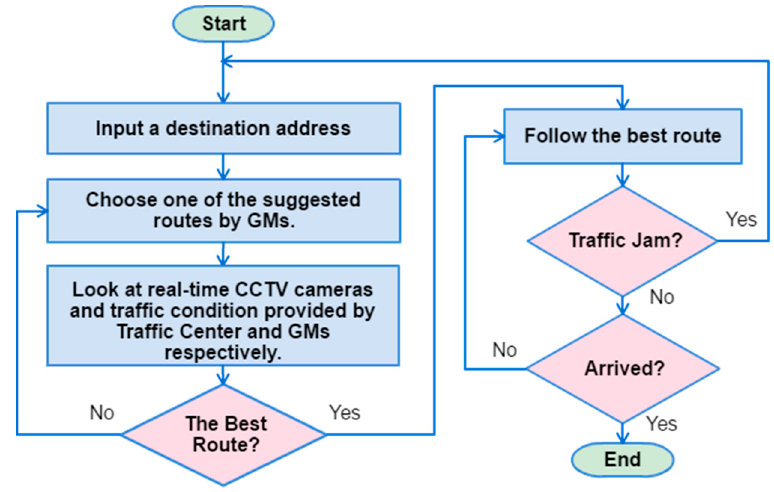
Figure 7. An algorithm to choose the best route.